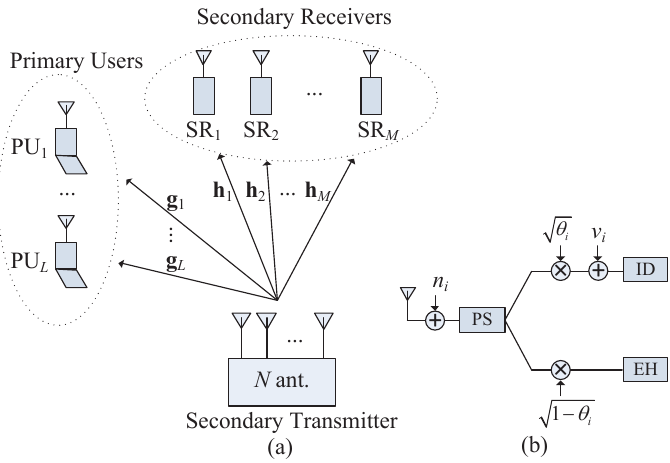
Figure 1. ( a ) The multi-input single-output (MISO) cognitive radio network being considered in the paper, and ( b ) the power-splitting receive model at SR i . PU: primary user; SR: secondary